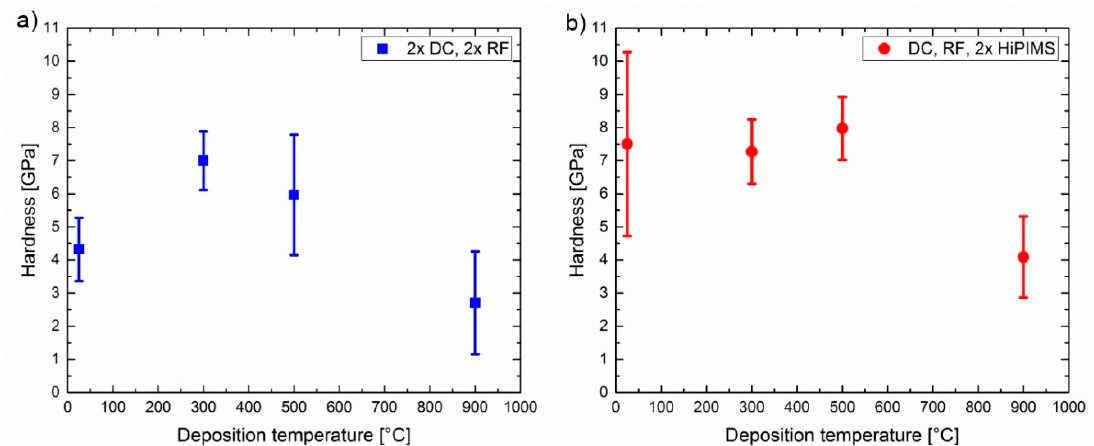
Figure 6. Hardness values as determined by nanoindentation of films deposited at different temperatures: ( a ) cathodes powered by two each DC and RF plasma generators. ( b ) cathodes powered by one DC and one RF generator, and two HiPIMS generators.